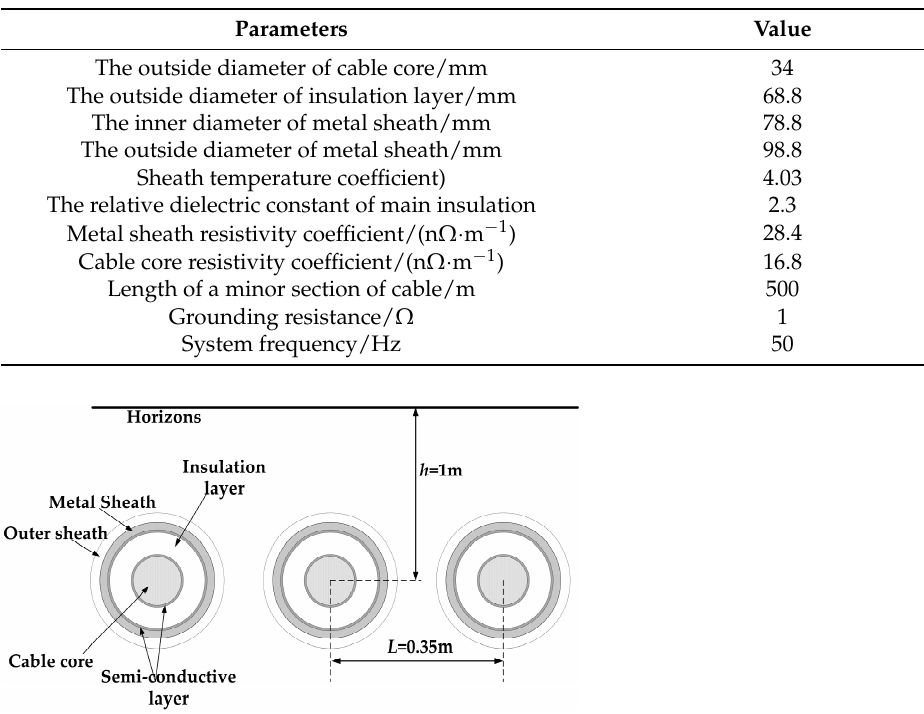
Figure 10. Schematic diagram of horizontal laying of three-phase cable.